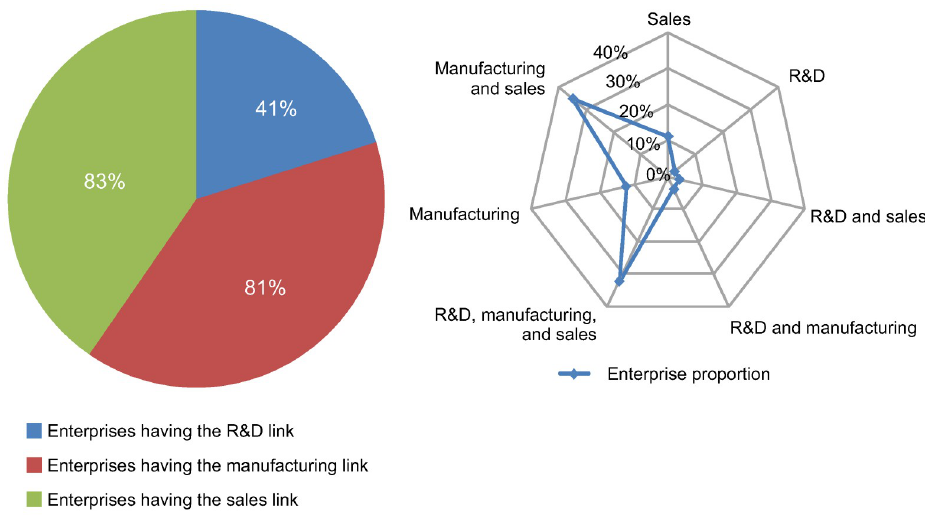
Fig 4. Proportions of Taiwanese-listed OTC electronic information enterprises for each value chain organization model.